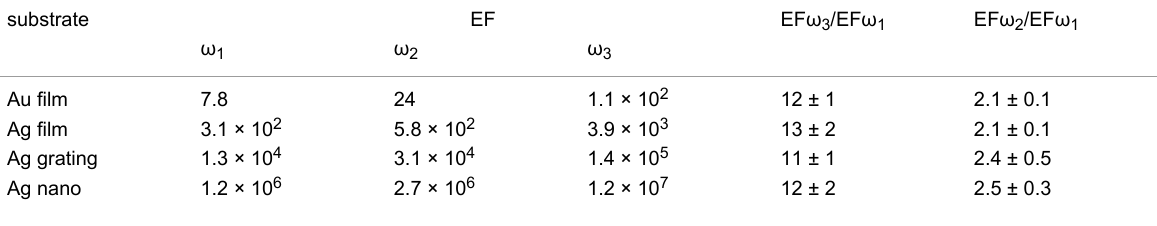
Table 1: Raman enhancement factors for different substrates with 633 nm